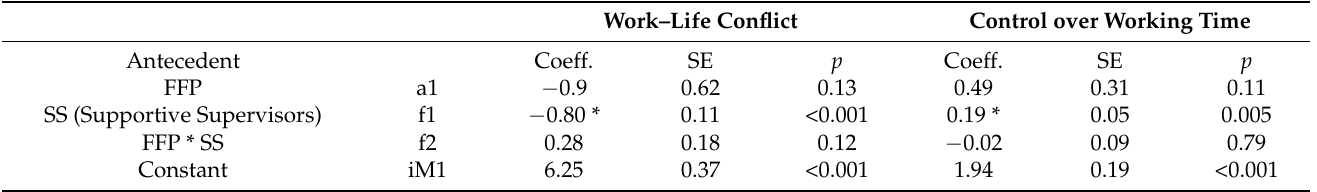
Table 4. Interaction of FFP provision and use with supportive supervisors, and association with work–life conflict and control over working